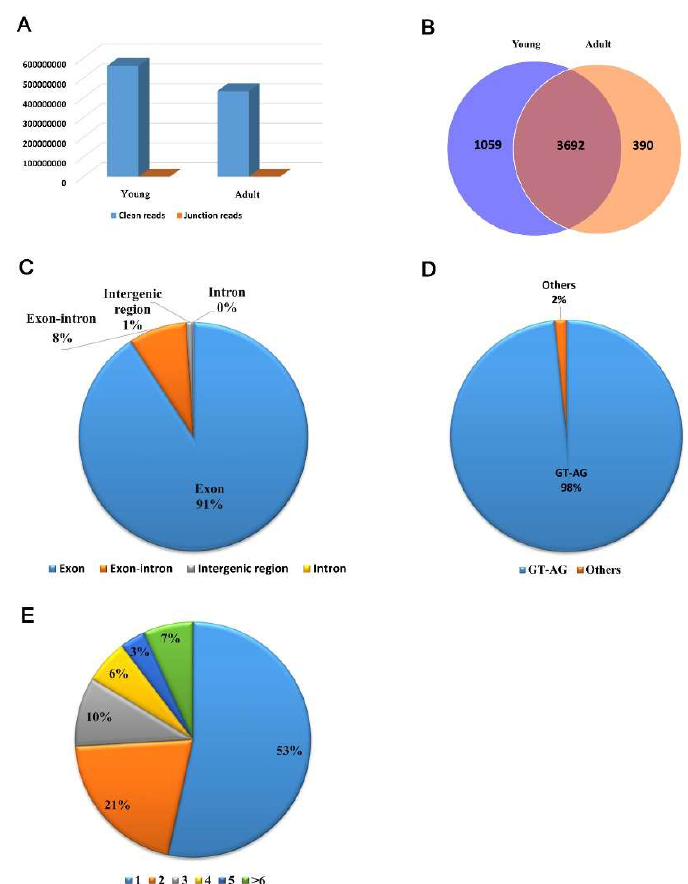
Figure 1. Profiling of circRNAs in young and adult Chinese buffalo adipose tissue. ( A ) Clean reads and junction reads obtained from young and adult buffalo adipose tissue. ( B ) circRNAs expressed in young and adult buffalo adipose tissue. ( C ) Overview of the types of total predicted circRNAs. ( D ) Splicing modes at the junctions. ( E ) Distribution of host genes producing different numbers of circRNAs. Different colors mean different numbers of circRNAs produced by the same host gene.